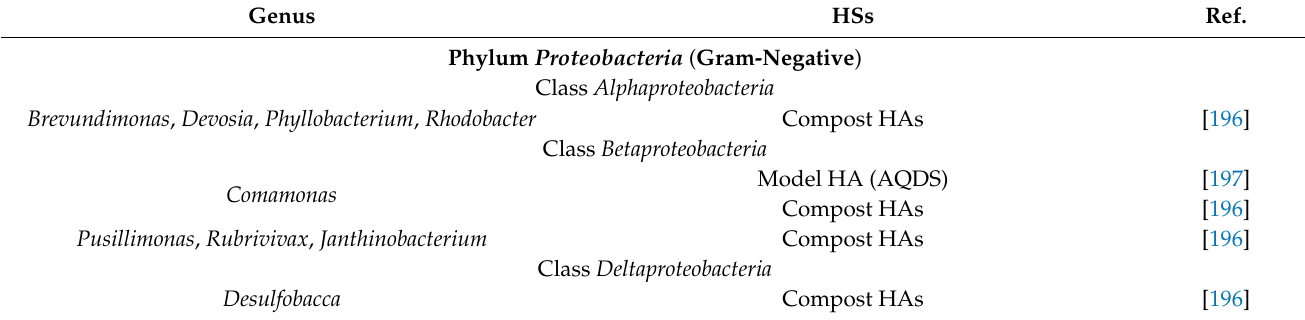
Table 4. Some genera of humic-reducing